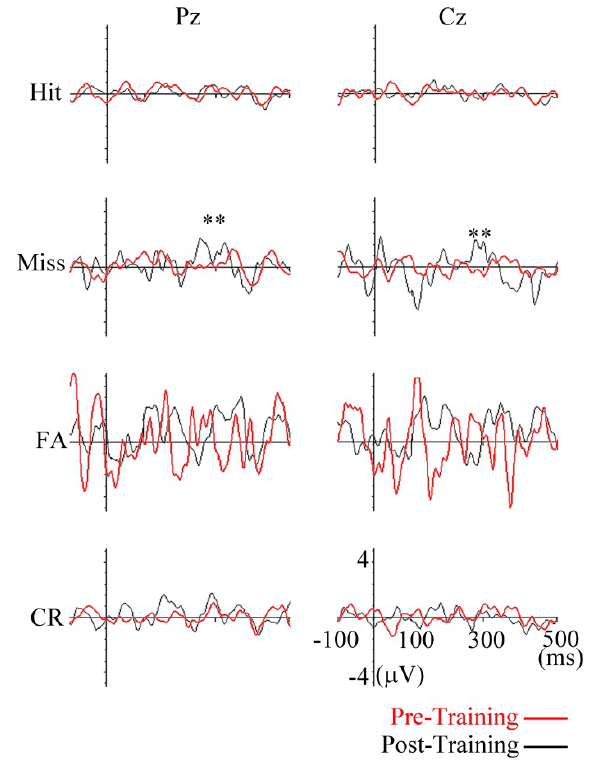
Figure 6 – FLERPs at electrodes Pz and Cz, shown as average amplitude (µV) over time (ms). The mean amplitudes of the P3 wave were analyzed using the ERP measurement tool in the ERPLAB package. A significant difference (**p ≤ 0.001) was only found for the miss